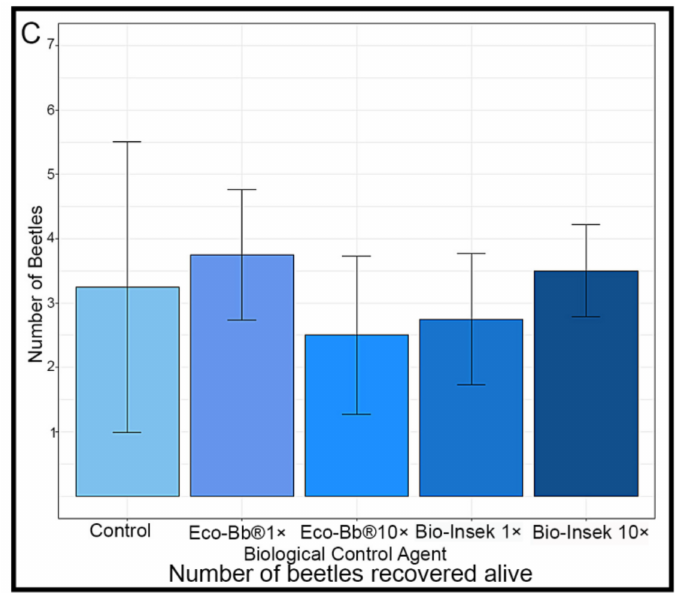
Figure 3. Bar charts showing ( A ) the average total number of beetles recovered, ( B ) the number of beetles that infested into the castor bean stems, and ( C ) the average number of beetles recovered alive from the trial replicates of the beetle boring assay. Error bars show plus or minus the standard error or the